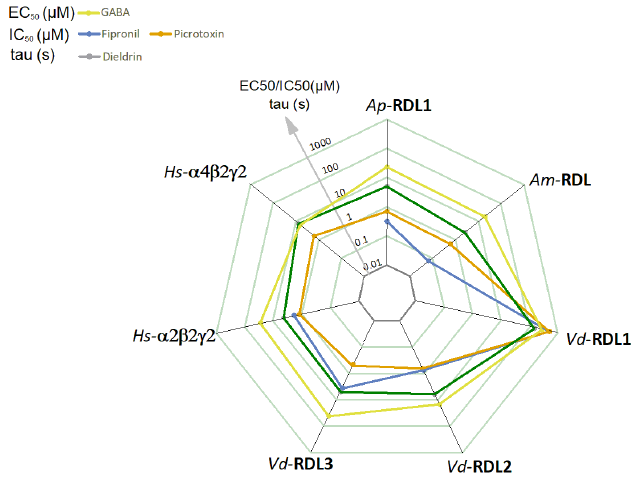
Figure 8. Radar graph summarizing the pharmacological data obtained with the different GABA-A receptors during this study. GABA (EC 50 in µ M and yellow), fipronil (IC 50 in µ M and blue), picrotoxin (IC 50 in µ M and orange) and dieldrin (Tau-block in seconds and in green) are shown; for values see Supplementary Table S1.